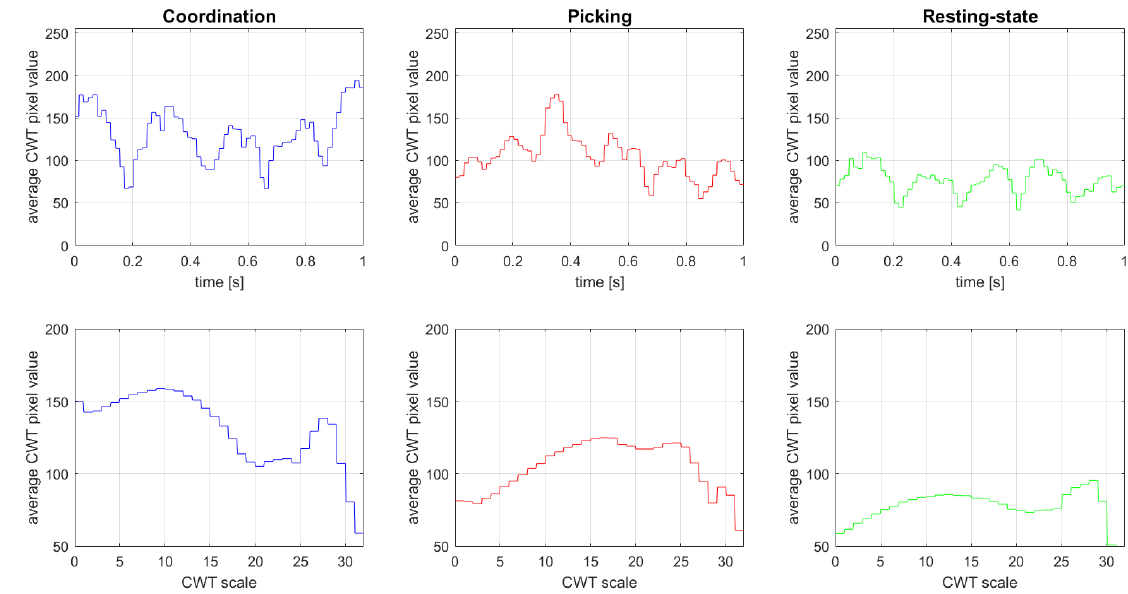
Figure 5. Analysis of Player #3 CWT images as a function of time and CWT scale factor.